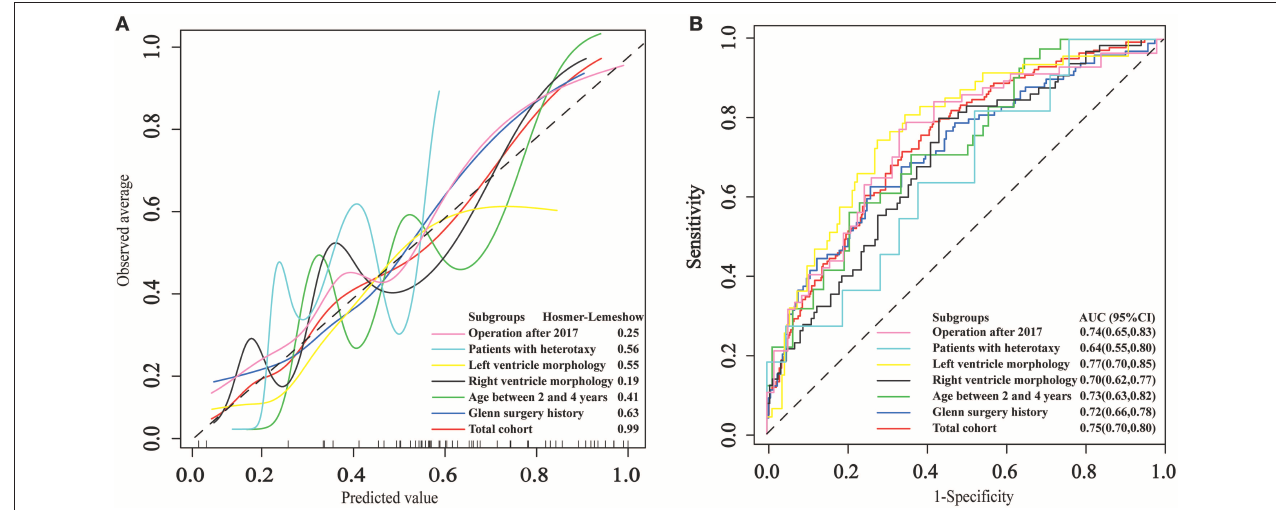
FIGURE 1 | The application and performance of the model in the total cohort and 6 subgroups. (A) Calibration curves of the logistic model. (B) Receiver operating characteristic curves for prolonged pleural effusion.